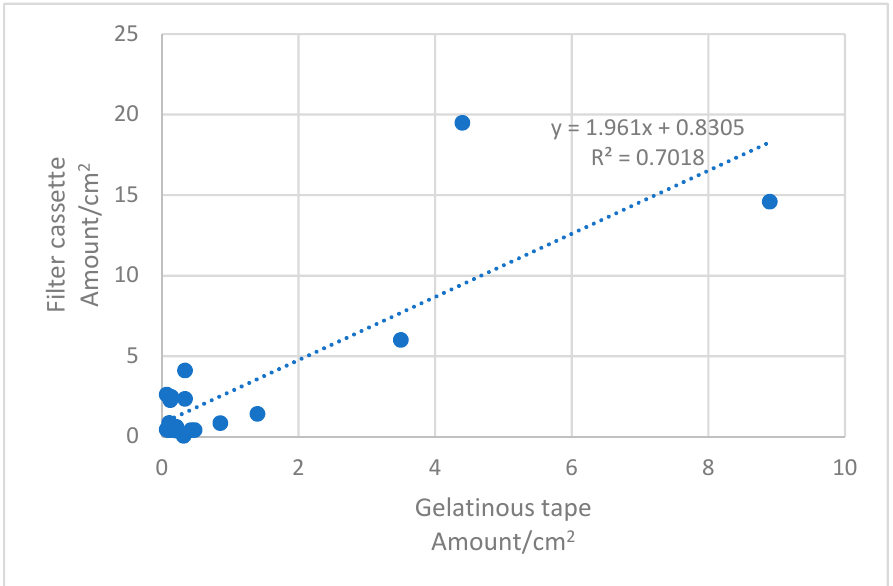
Figure 2. Fiber counts in office-type environments using the adhesive tape method (x) and the filter cassette method (y) ( n = 20). The dotted line represents the regression line (y = 1.96x + 0.83).